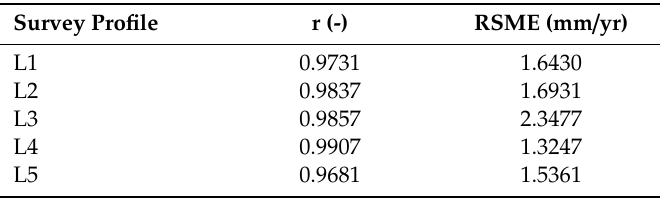
Table 3. Summary of the PSI potential in predicting levelling results.